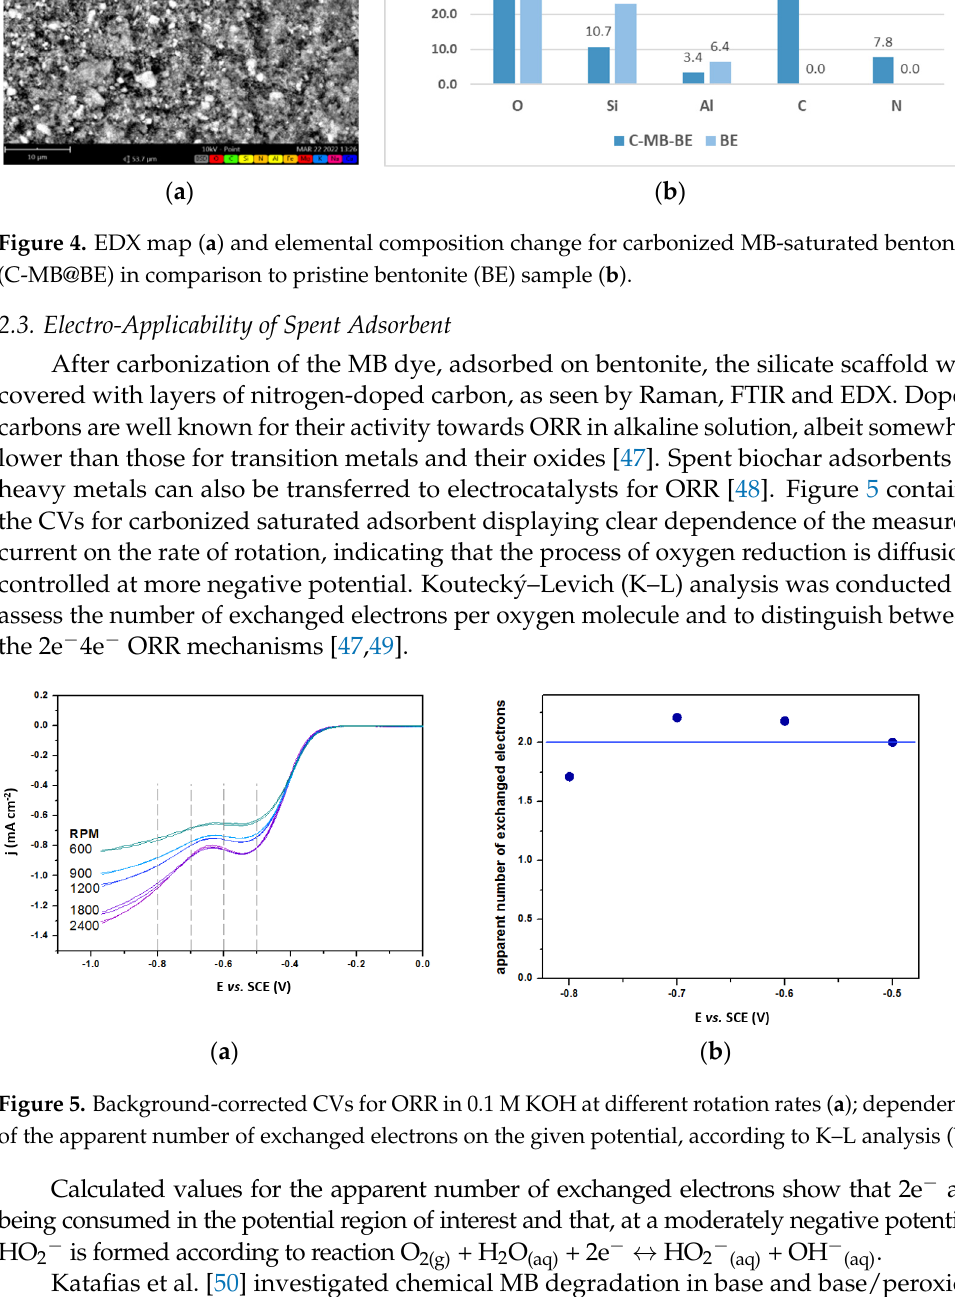
Figure 4. EDX map ( a ) and elemental composition change for carbonized MB-saturated bentonite (C-MB@BE) in comparison to pristine bentonite (BE) sample ( b ).